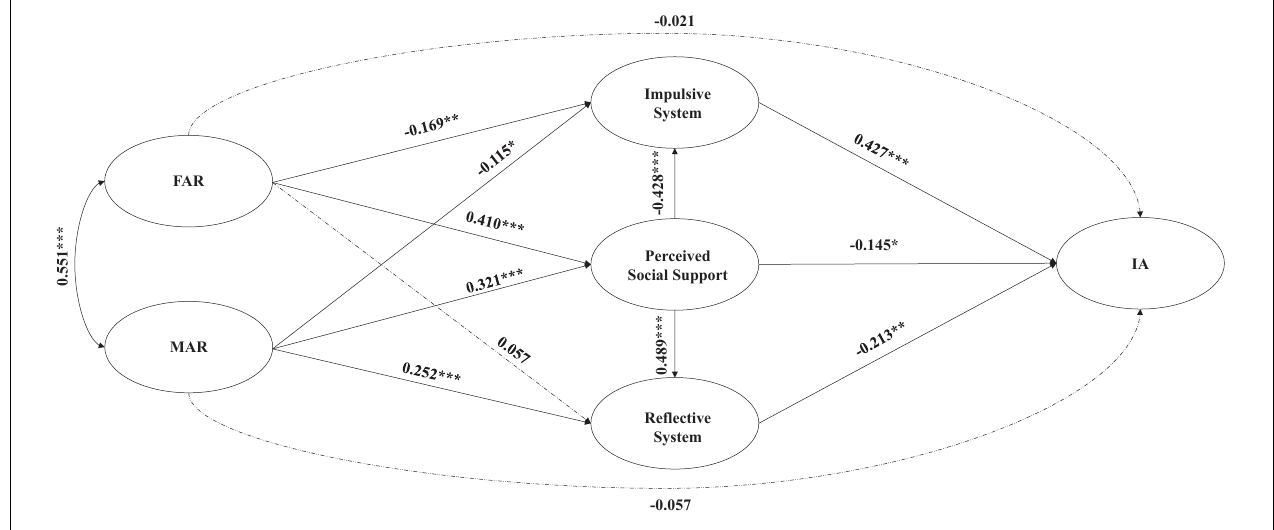
FIGURE 2 | Hypothesis model. The dashed lines indicate paths with non-significant regression coefficients; control variables and precursor measures are not